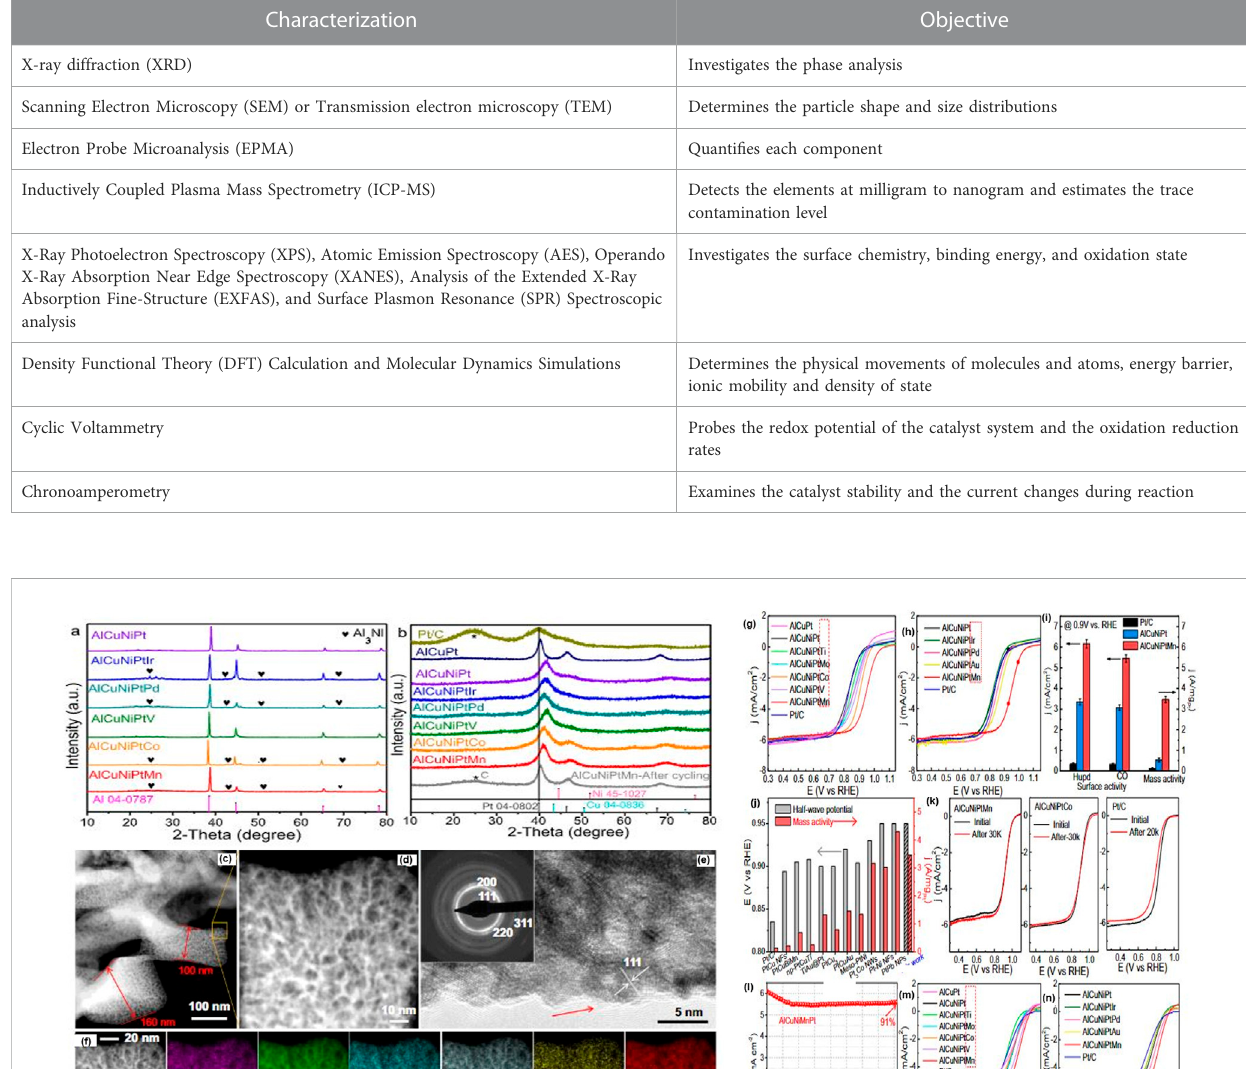
TABLE 1 Tabular Representation of Various Characterization Tools for Determining the Properties of HE-NPs for catalytic Applications. Characterization